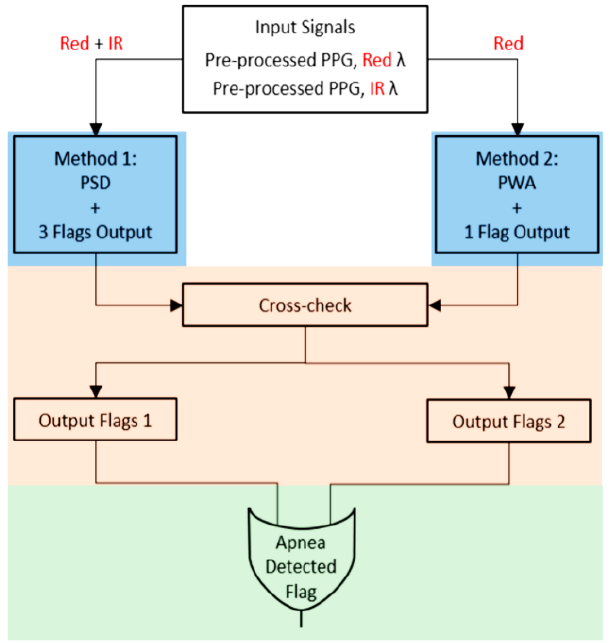
Figure 14. Schematization of the algorithm proposed in [115] for detecting apneas.